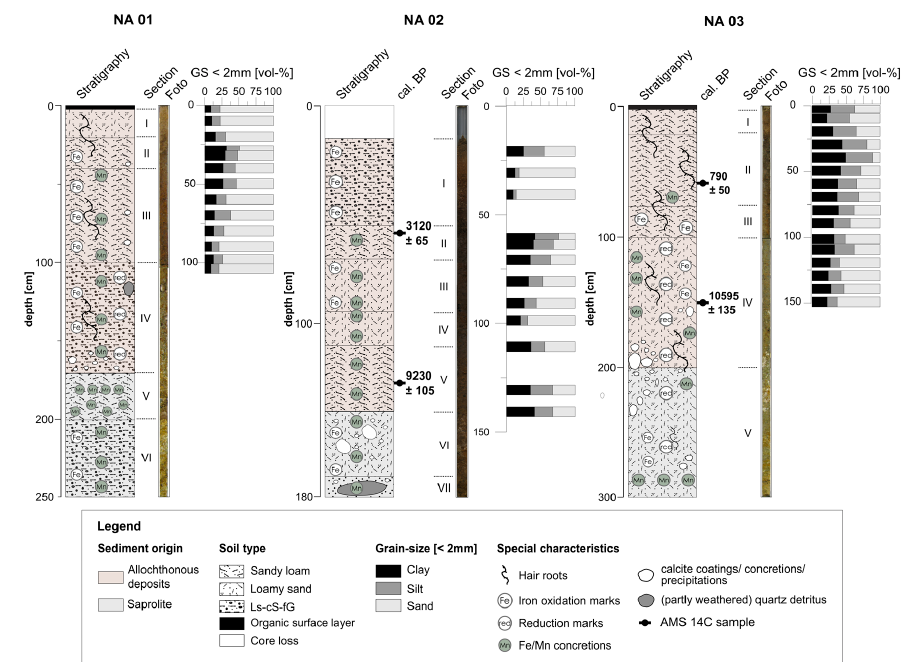
Figure 4. Lithostratigraphy of sediment profiles NA01, NA02 (tank 6) and NA03 (tank 5) in system 2.